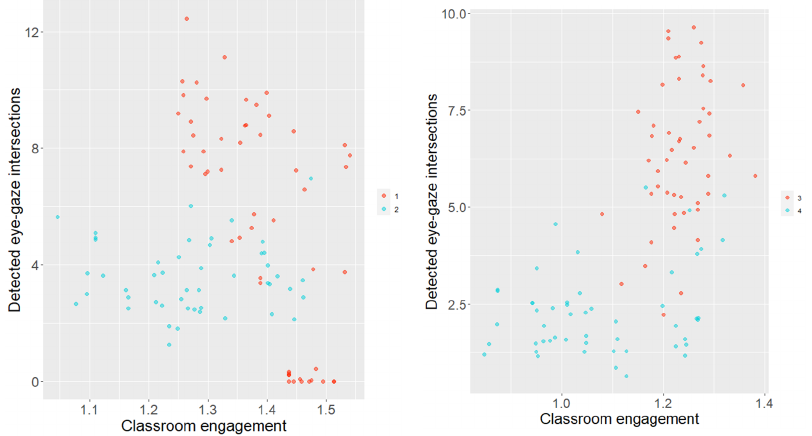
Figure 8. Detected eye-gaze intersections as a function of the classroom